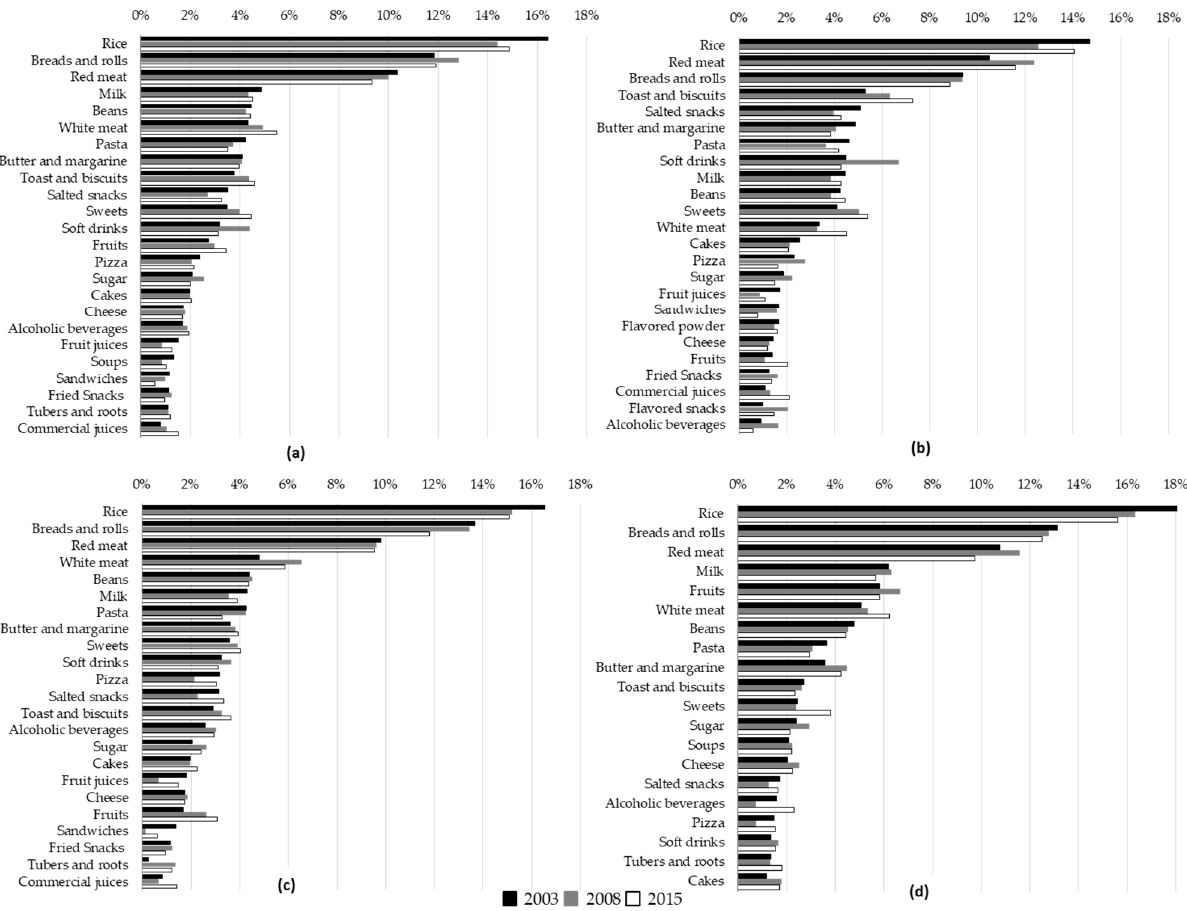
Figure 1. Percentage of energy contribution (%) of food groupings consumed by the population of the ISA-Nutrition in 2003, 2008, and 2015. ( a ) Description of total population; ( b ) Description of adolescents; ( c ) Description of adults; ( d ) Description of older adults. The list of foods included in each food grouping is described in